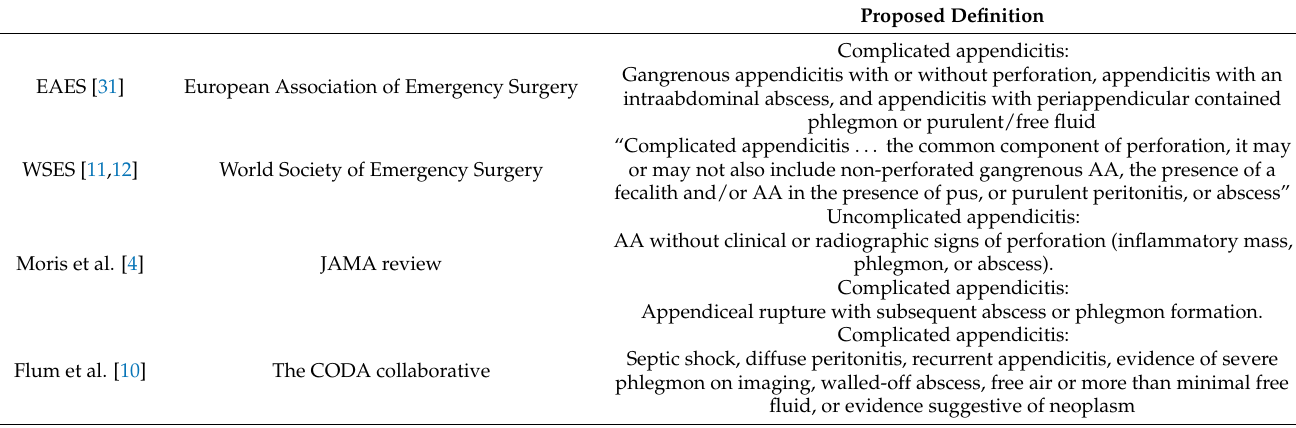
Table 1. Proposed definition of uncomplicated/complicated